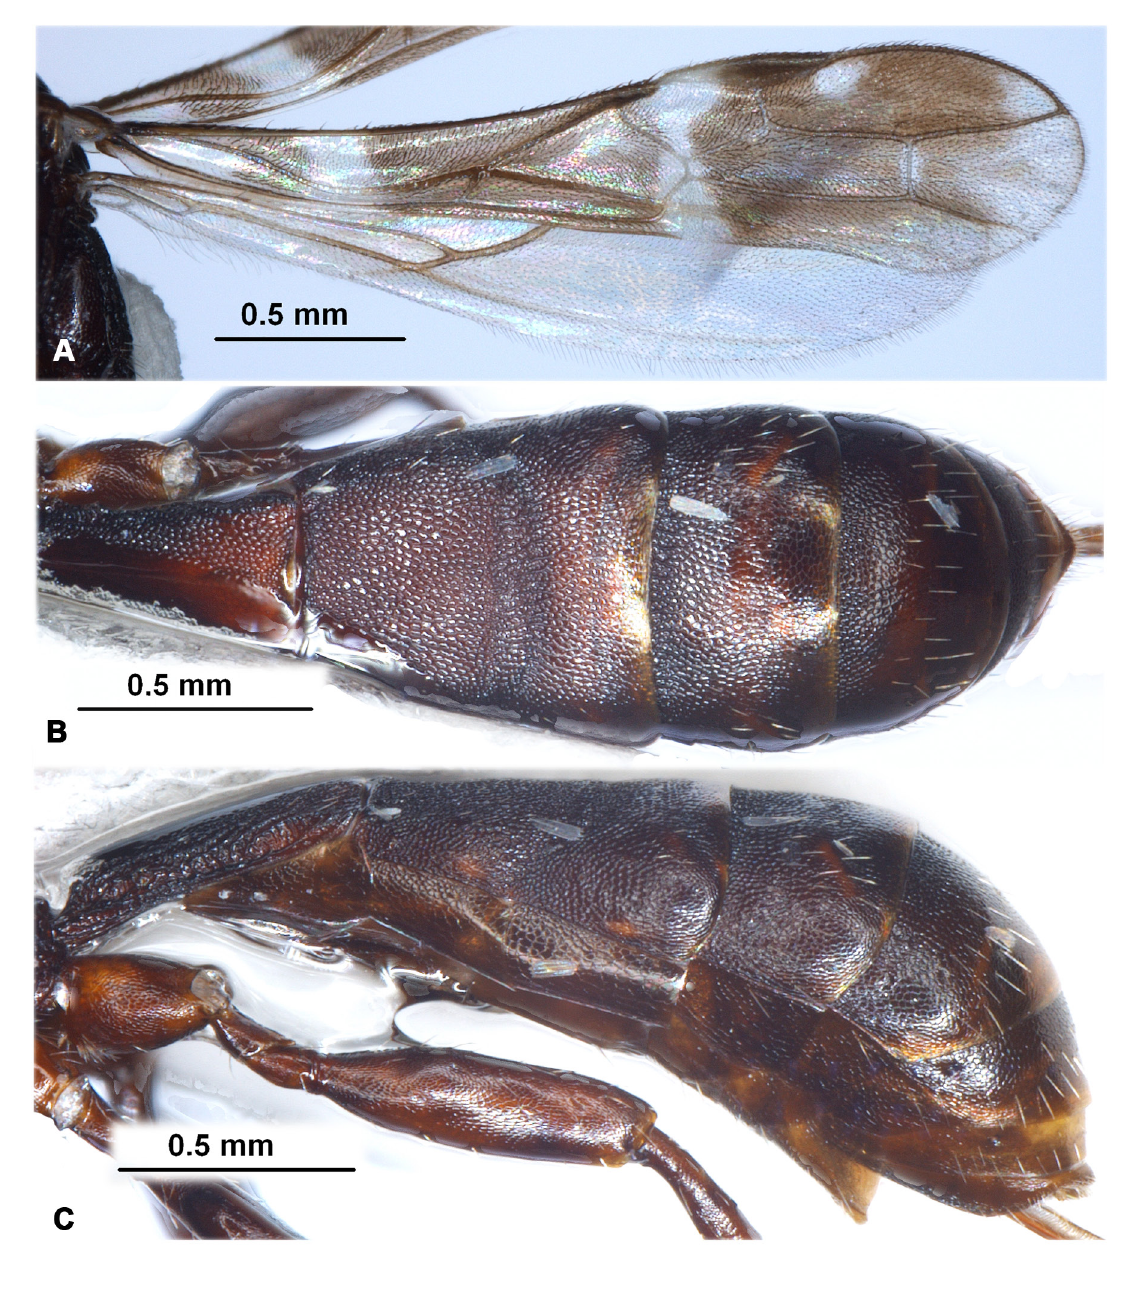
Fig. 42. Platyspathius ( P. ) longicaudis Belokobylskij sp. nov., holotype, ♀ (RMNH). A . Wings. B . Metasoma, dorsal view. C . Metasoma, lateral